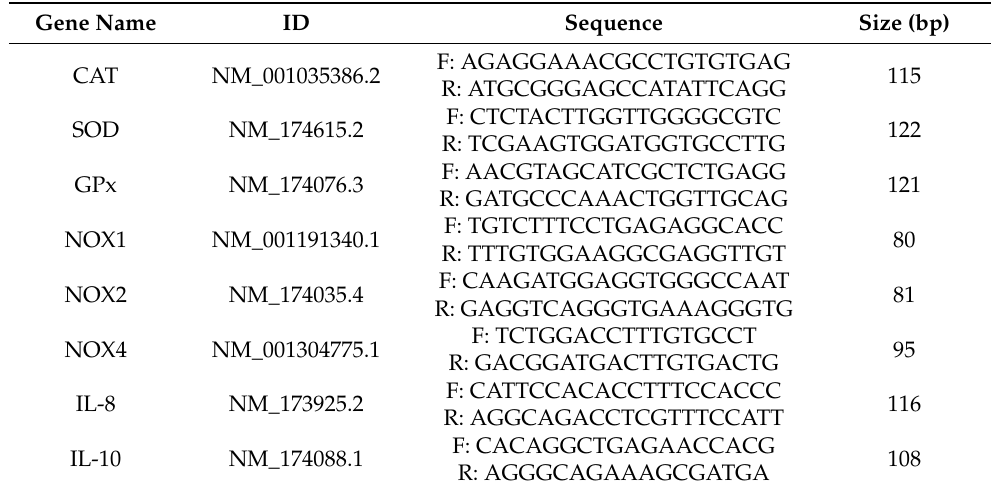
Table 2. Primer pairs used for